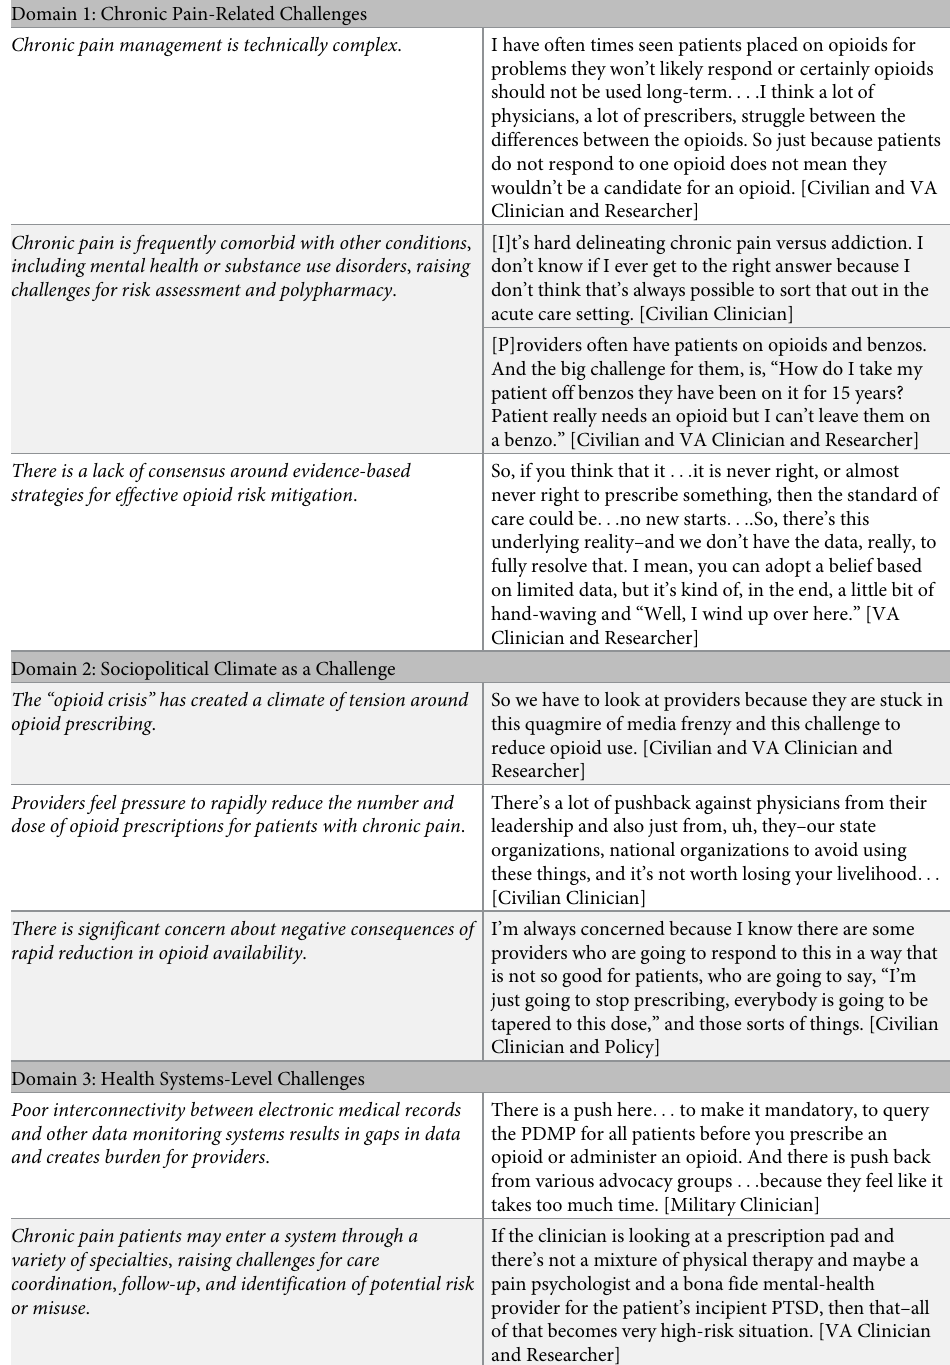
Table 2. Multifactorial challenges in chronic pain management and opioid risk mitigation identified by expert